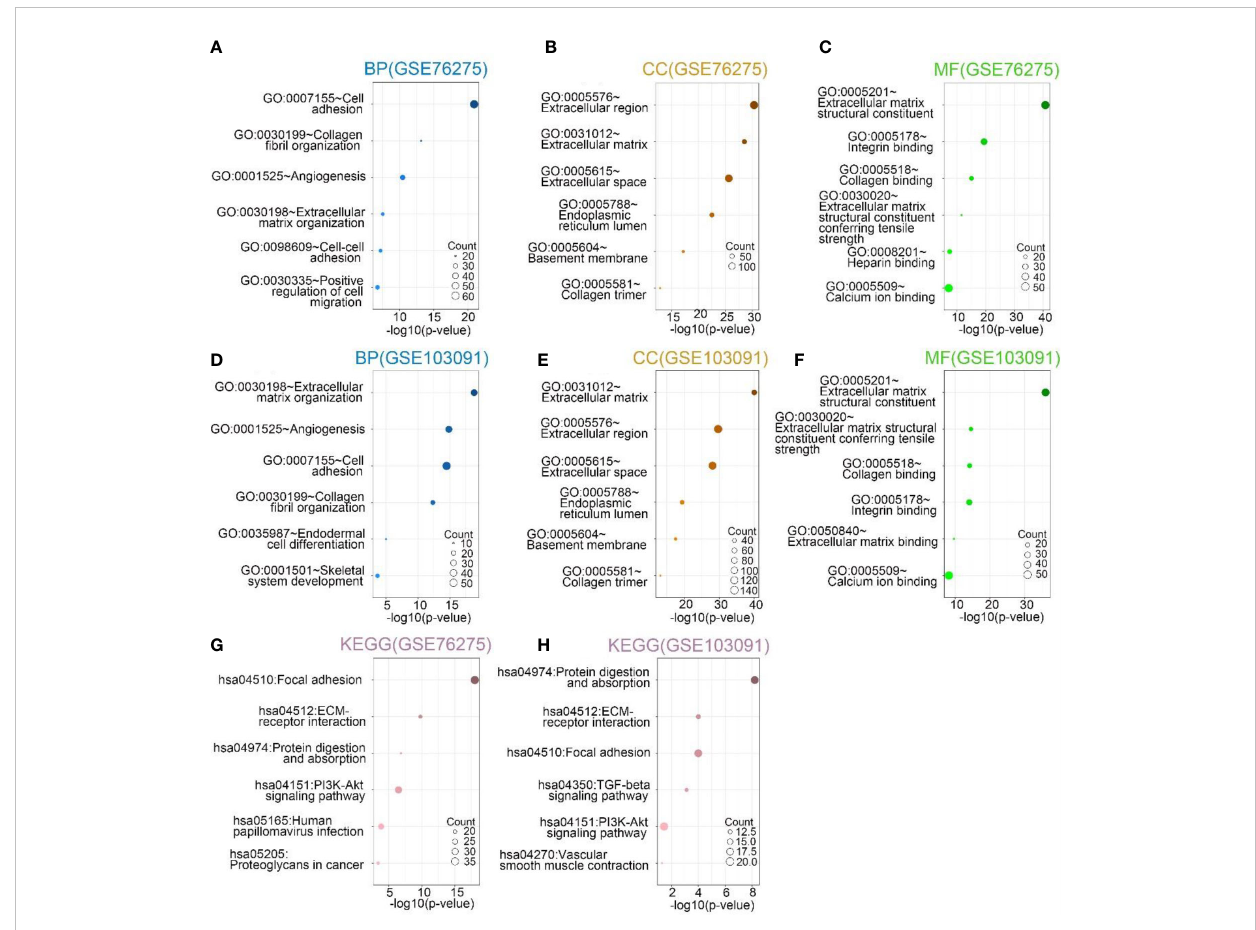
FIGURE 2 (A – C, G) In GSE76275, the top 6 biological processes (BPs), cellular components (CCs), and molecular functions (MFs), Kyoto Encyclopedia of Genes and Genomes (KEGG) pathway analysis most related to SPON2. (D – F, H) In GSE103091, the top 6 biological processes (BPs), cellular components (CCs), and molecular functions (MFs), Kyoto Encyclopedia of Genes and Genomes (KEGG) pathway analysis most related to